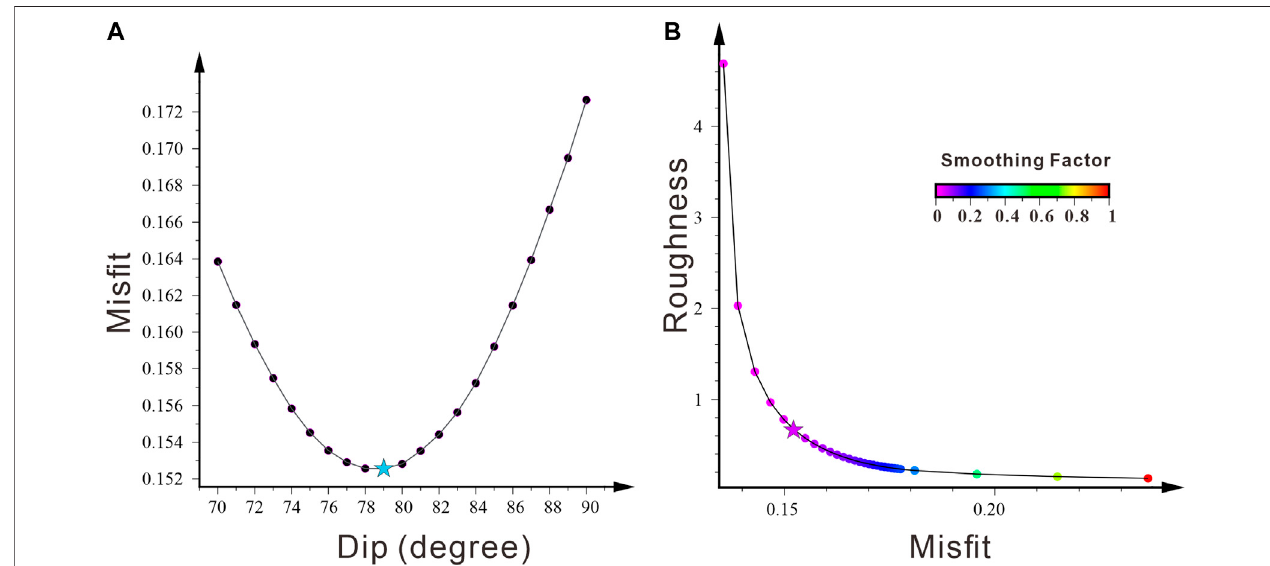
FIGURE5| Determination oftheoptimal fault dip angle and thesmoothing factor. (A) Themis fi t-dip curve. Thelightblue star indicates the optimal dip angle of79 ° . (B) The model roughness and the fi tting residual curve. The star indicates the best smoothing factor of 0.05.